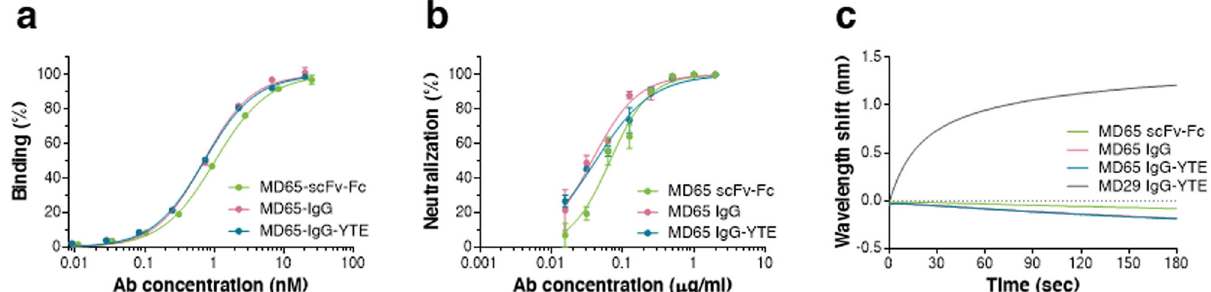
Fig. 1 Characterization of the MD65 Ab versions. a Binding pro fi les of MD65 Ab variants (speci fi ed by different colors as indicated in the respective inset legends) tested by ELISA against S1. Values along the curve depict averages of triplicates ± SEM. b SARS-CoV-2 in vitro neutralization potency of the MD65 Ab variants evaluated by plaque reduction neutralization test (PRNT). Values are averages of triplicates ± SEM. c BLI-determined binding of hACE2 to RBD in the presence of MD65 Ab variants or MD29 IgG-YTE (as a control). Each of the biotinylated antibodies was immobilized on a streptavidin sensor, saturated with RBD, washed, and incubated with recombinant hACE2 for 180 s. Time 0 represents the binding of the hACE2 to the antibody – RBD complex. The MD65 IgG curve completely overlapped with and is therefore masked by the MD65